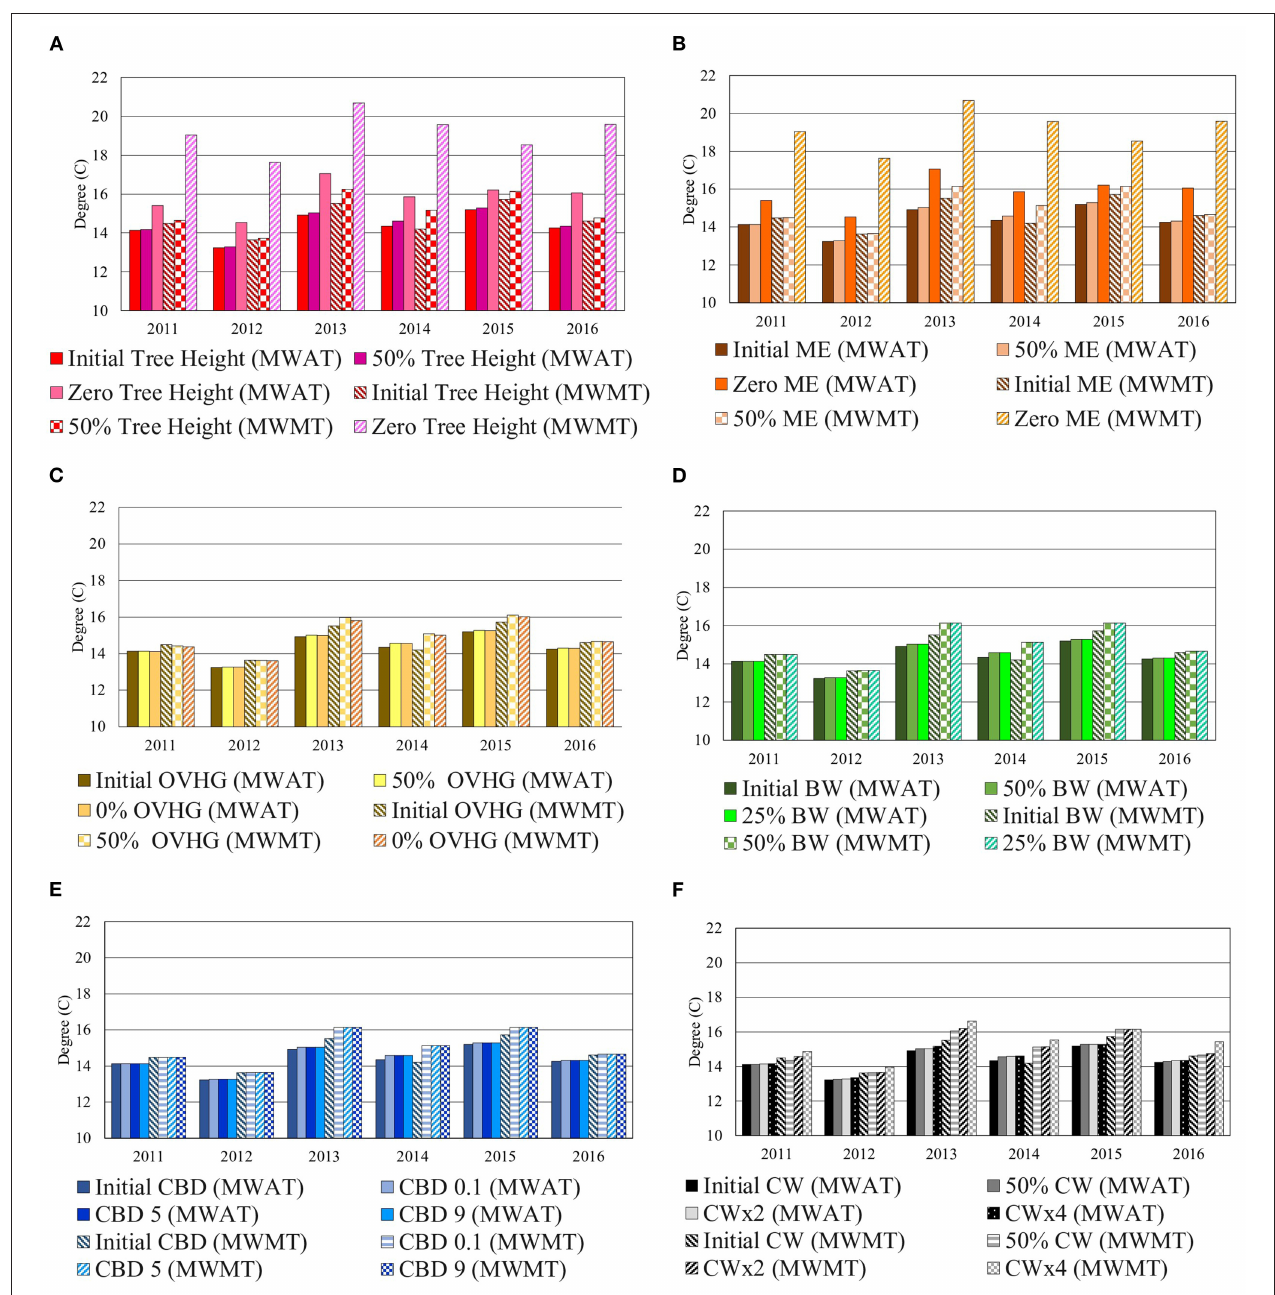
FIGURE 4 | Modeled temperature responses to changes in (A) tree height, (B) monthly extinction coefficient, (C) overhang coefficient, (D) buffer width, (E) canopy bank distance, and (F) channel width, to assess model sensitivity. Bars that are solid represent MWAT results, while bars that are the same color but with strips, represent the MWMT results for that same reduced or increased value.